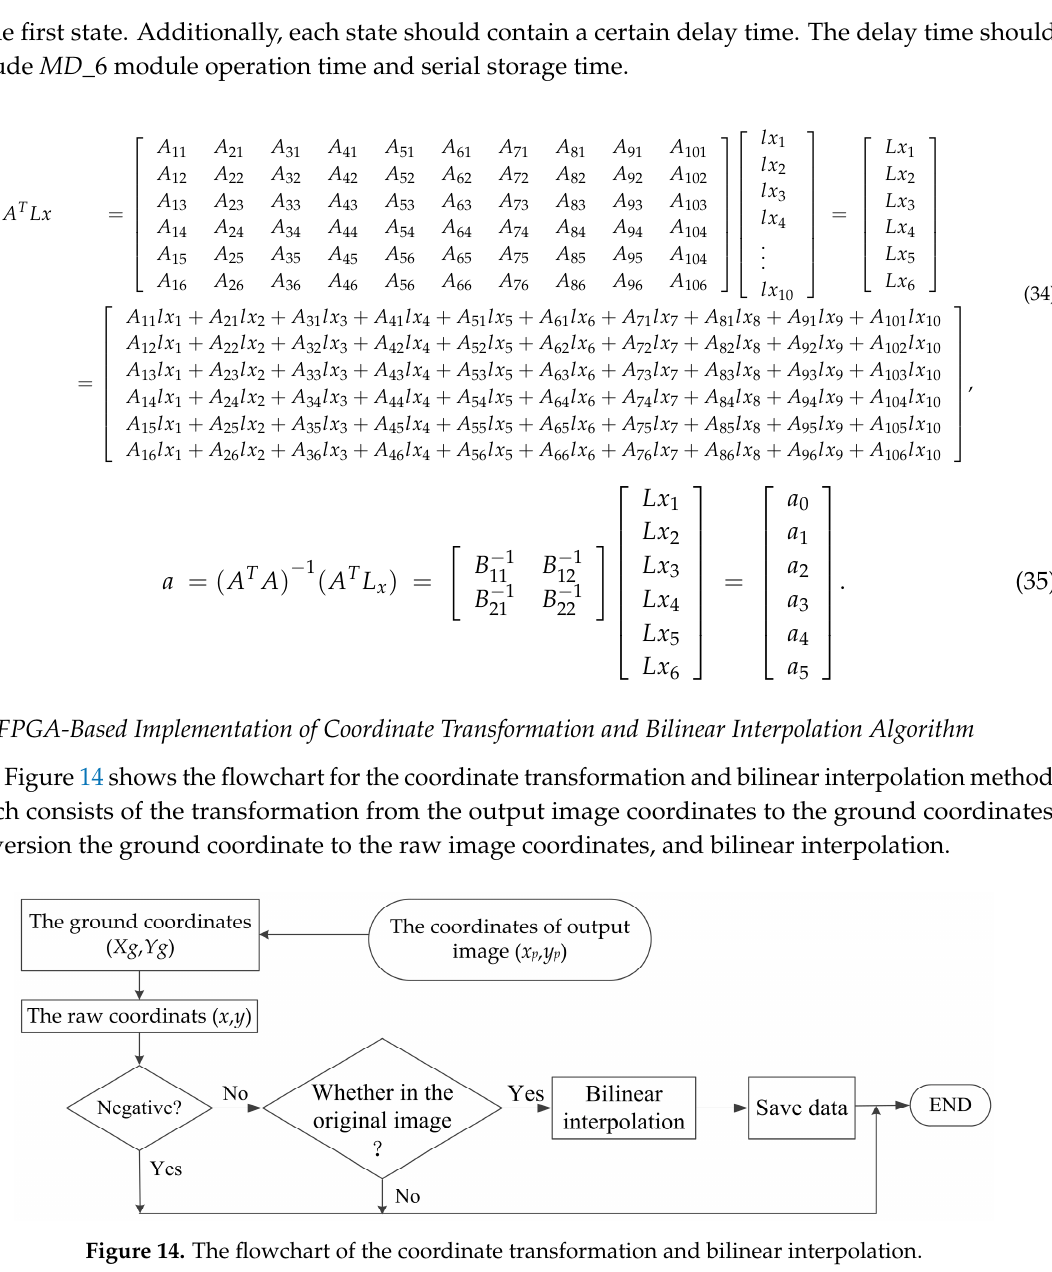
Figure 15. Parallel computation method for